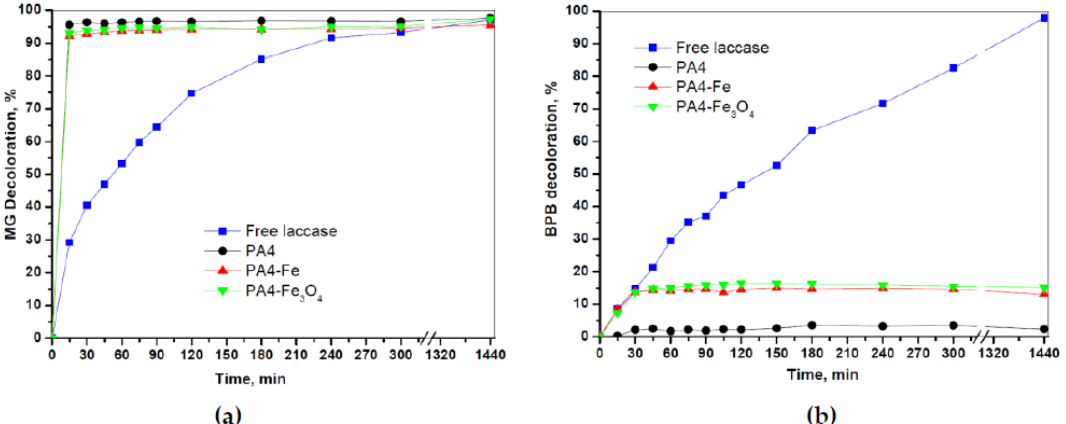
21 of 30 Figure 11. Decolorization of: ( a ) , ( b )—malachite green (MG) and ( c ), ( d )—bromophenol blue (BPB) by PA4@iL or PA4@eL samples. The decolorization percentage was calculated according to Equation 5 (see Materials and Methods, Section 3.3.5.). The decolorization of BPB occurred quite differently with a clear dependence on the way of enzyme incorporation into the PA4 support microparticles. The adsorption-immobilized PA4@iL samples were less active than the free laccase, showing a lower decolorization effectiveness within the whole 24 h period that peaked only around 25–50% (Figure 11c,d). At the same time, the two laccase-entrapped samples PA4-eL and PA4-Fe-eL displayed values of 70–80% in 120 min, the free laccase value being 45% at this time. A final decolorization of 80–90% was achieved after 24 h against 100% of the free enzyme. The PA4-Fe 3 O 4 -eL sample maintains an effectiveness of ca. 50% after 150 min that almost coincides with that of the free laccase. From this point on, the decolorization rate of the free enzyme continues to increase linearly, whereas that of the Fe 3 O 4 -containing conjugate saturates. Our results on the BPB decolorization can be favorably compared to the data of Forootanfar et al. [47] who performed decolorization studies of BPB with free laccase from Trametes versicolor and reached effectiveness values of 20% after 180 min without mediator and 32% with HBT mediator Comparing the rates of decolorization of the two dyes by free laccase (Figure 11) suggests that the MG substrate is more susceptible to oxidative degradation than BPB. This experimental fact can be related to their different chemical structure. Thus, BPB contains bulky and heavy groups (four Br